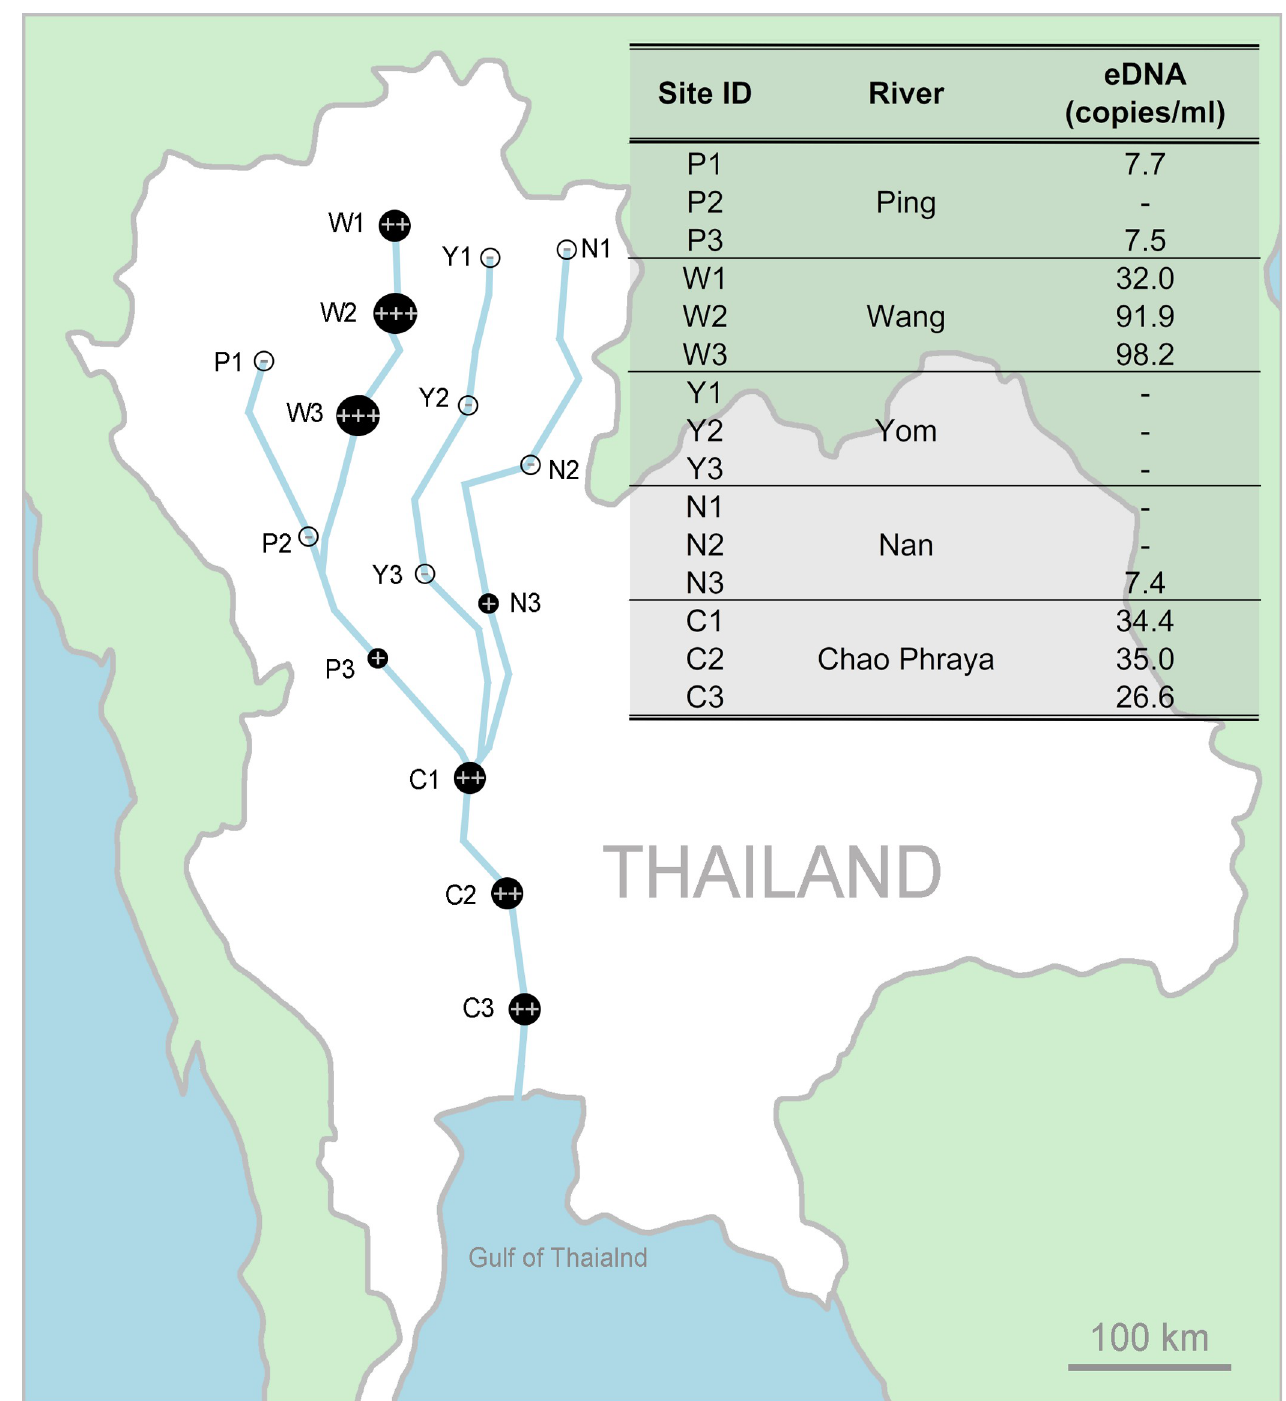
Fig 1. Map showing sampling sites in the Chao Phraya River Basin. Sites on the Ping River (P1-P3), sites on the Wang River (W1-W3), sites on the Yom River (Y1-Y3), sites on the Nan River (N1-N3) and sites on the Chao Phraya River (C1-C3). Giant snakehead eDNA concentration (copies per ml) detected at each site is